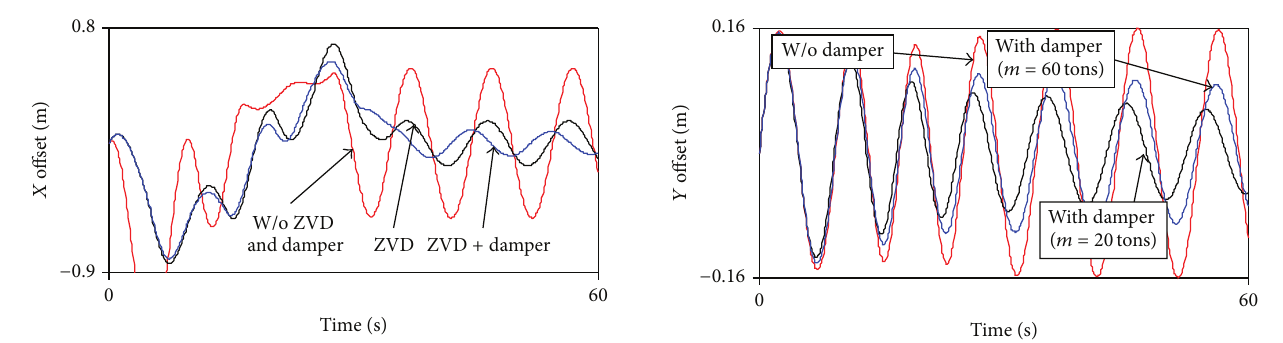
Figure 4: Spreader 𝑋 -offset in the case 𝑚 = 20 tons, 𝛾 = 0.1 .